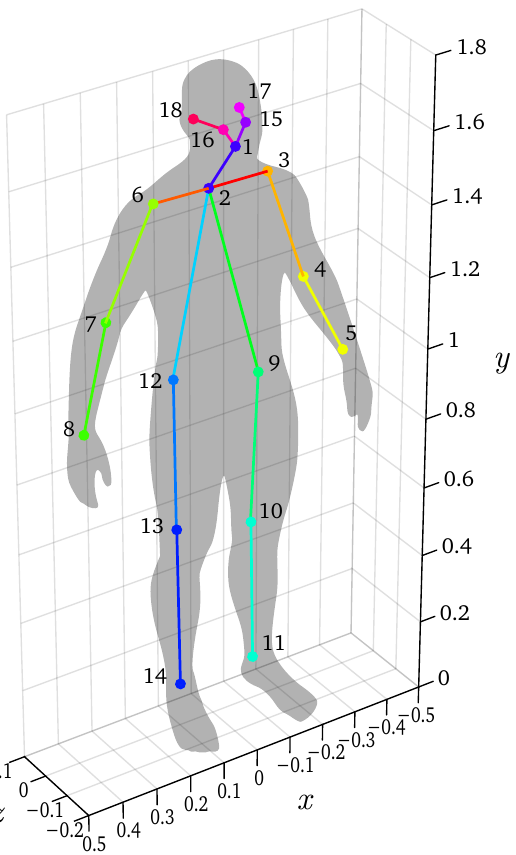
Figure 2. The used skeleton